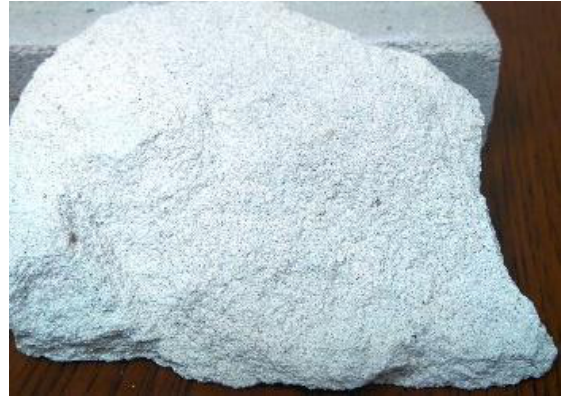
Figure 3. Fragment of reference brick made with quartz sand (QS).